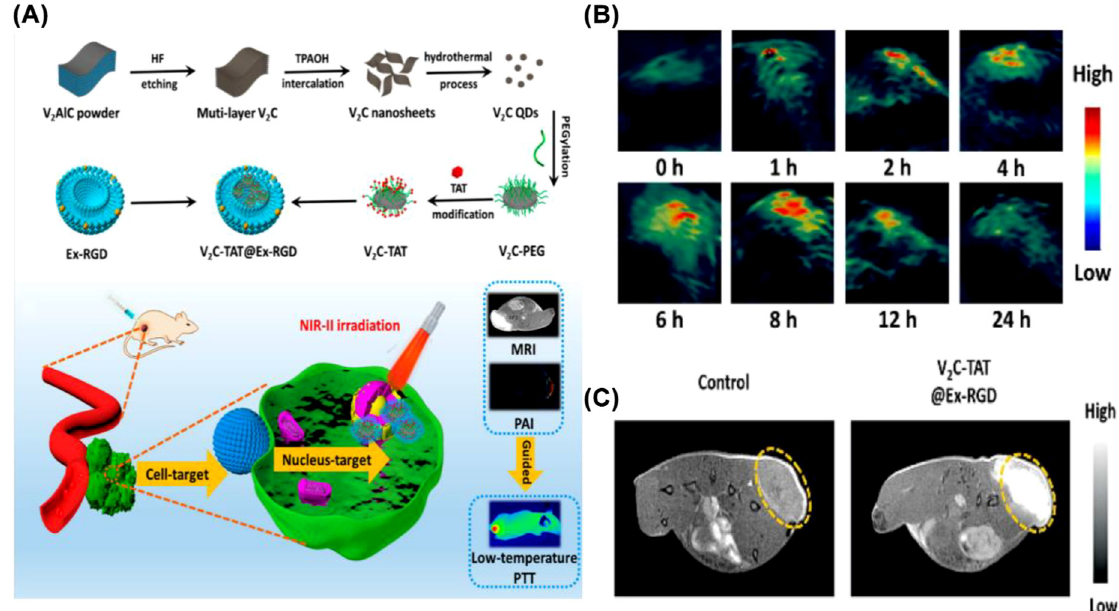
C-TAT@Ex-RGD and multimodal 2 C-TAT@Ex-RGD (right) [34]. 2